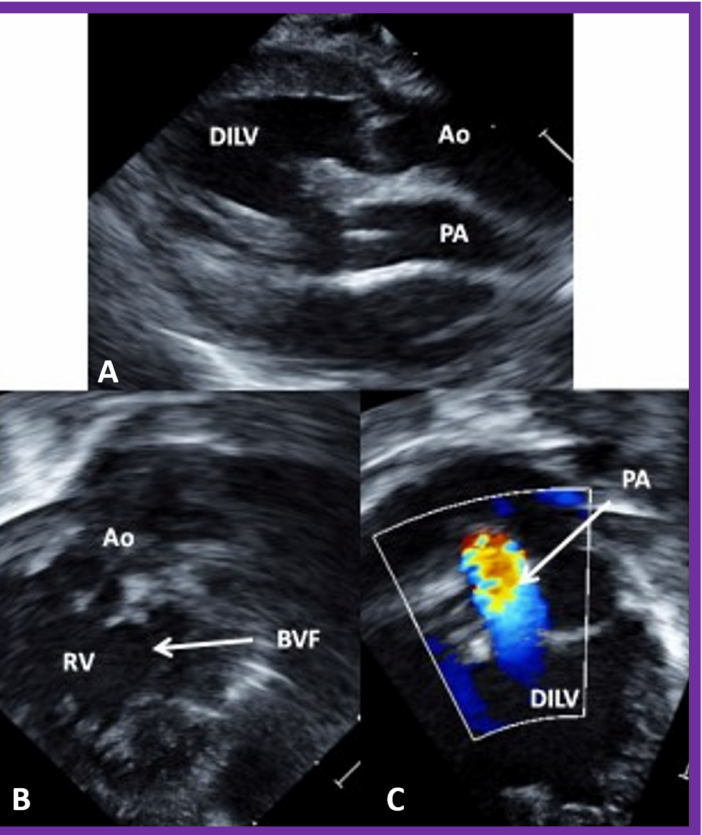
Figure 4. The 2D echo/color Doppler images from the parasternal long axis ( A ) and modified apical ( B , C ) projections of the case illustrated in Figure 3, indicating transposed great arteries ( A ). Note